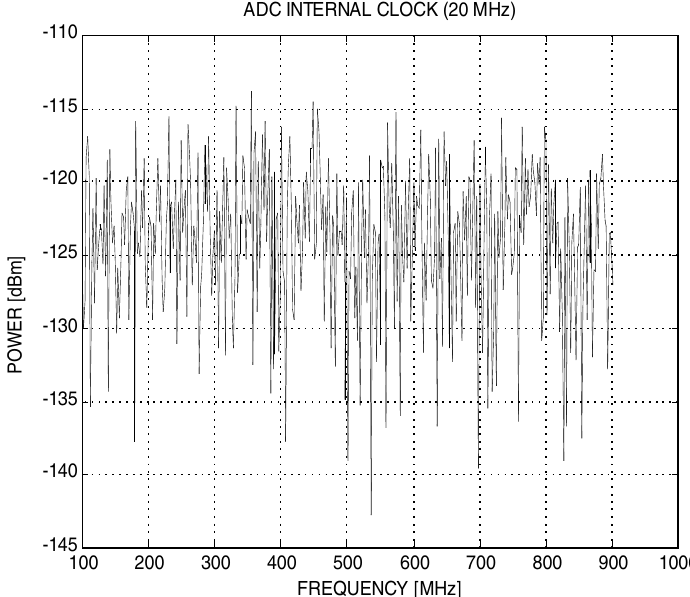
Fig. 5. Result of an averaging performed on the noise generated by the clock internal to the